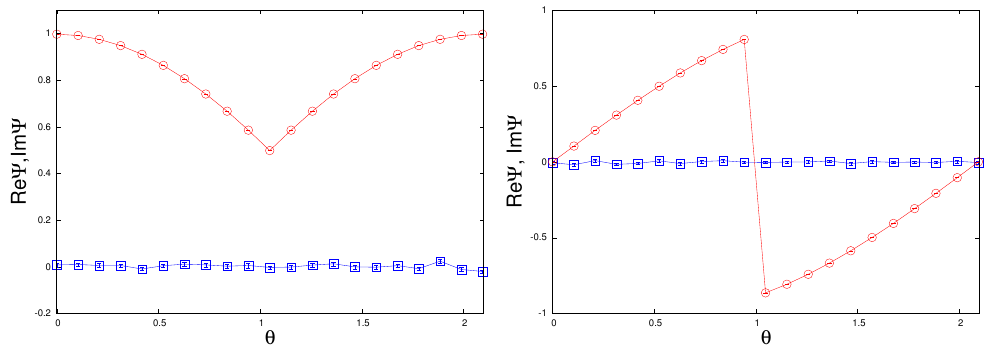
Figure 1. The θ -dependence of Ψ at θ = 0 and π /3 − (cid:101) , where we set to (cid:101) = 10 − 3 . The ( left ) and ( right ) panels show the real and imaginary parts of Ψ , respectively. The circle and square symbols are the results of the high- and low-temperature situations, respectively. Lines in all panels in this paper are the eye